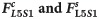
Results for FL5S1candFL5S1s in all four RTs.Axial compression force (FL5S1c, upper row) and anterior shear (FL5S1s, lower row) computed in relation to changes in sacral slope (SS) and pelvic incidence (PI) in the four lumbar typologies (RT1, RT2, RT3, RT4). The results for the three sagittal vertical axis (SVA) conditions interpreting the balanced global alignment (SVAmed) and the backward and frontward imbalanced alignments (SVAback and SVAfront) are presented as green, blue, and red surfaces, respectively.